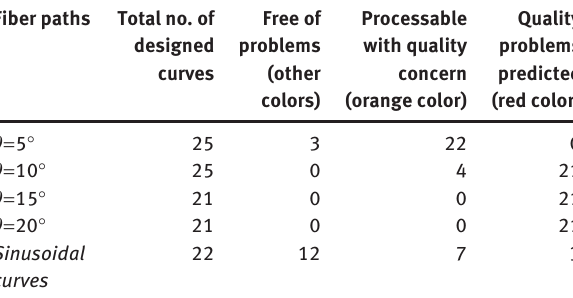
Table 2 Summary of fiber steering simulation results. Fiber paths